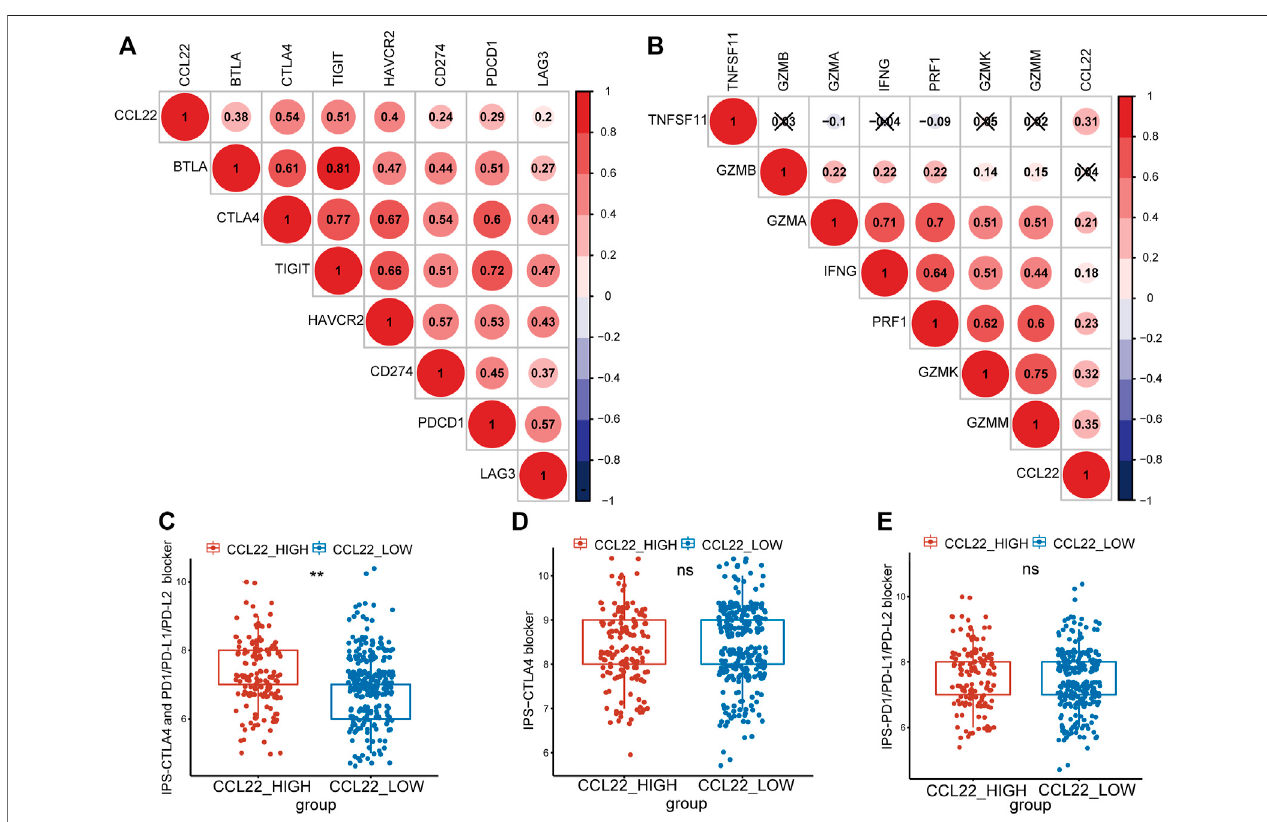
FIGURE6| RelationshipbetweenCCL22expression and responsetoimmune checkpoint inhibitors. (A) The correlation between CCL22expression and immune checkpoint genes and (B) cytotoxic genes. Red is positive, and blue is negative. The symbol “ x ” represented a p -value > .05, and the circles without “ x ” meant p -value < .05. The numbers in the circle represented the correlation value. Box plots showing the association between (C) IPS-CTLA4and PD1/PD-L1/PD-L2, (D) IPS-CTLA4, and (E) IPS-PD1/PD-L1/PD-L2 scores and CCL22 expression in patients of The Cancer Genome Atlas colon adenocarcinoma.